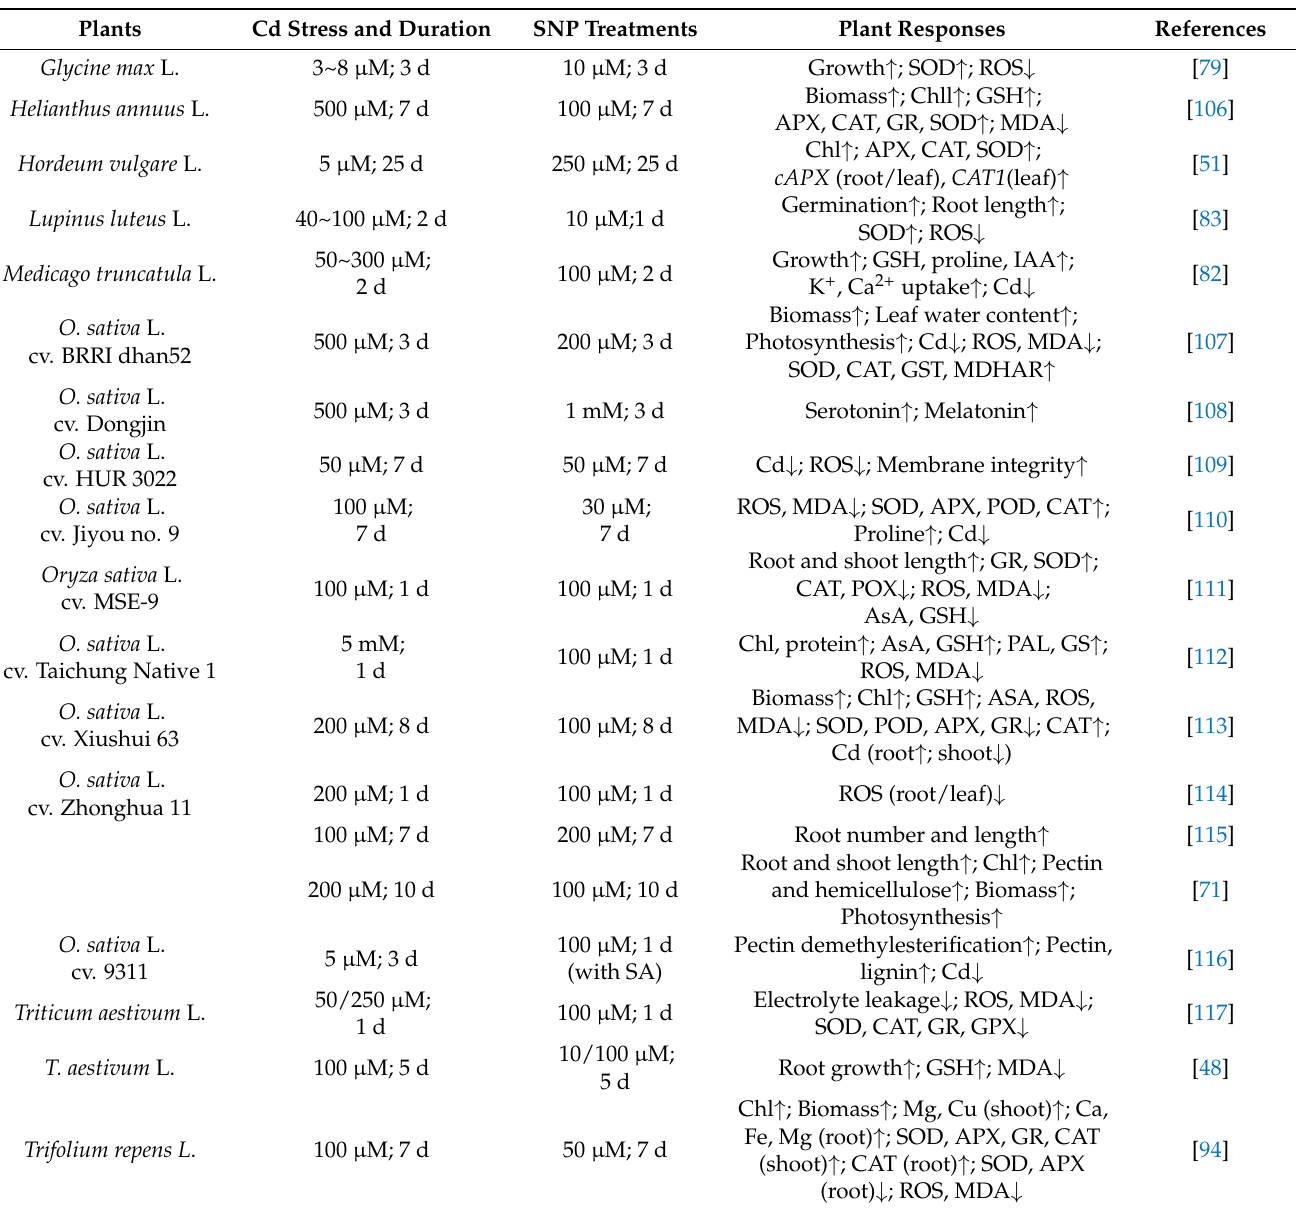
Table 2. Effect of exogenous NO on plant response to Cd